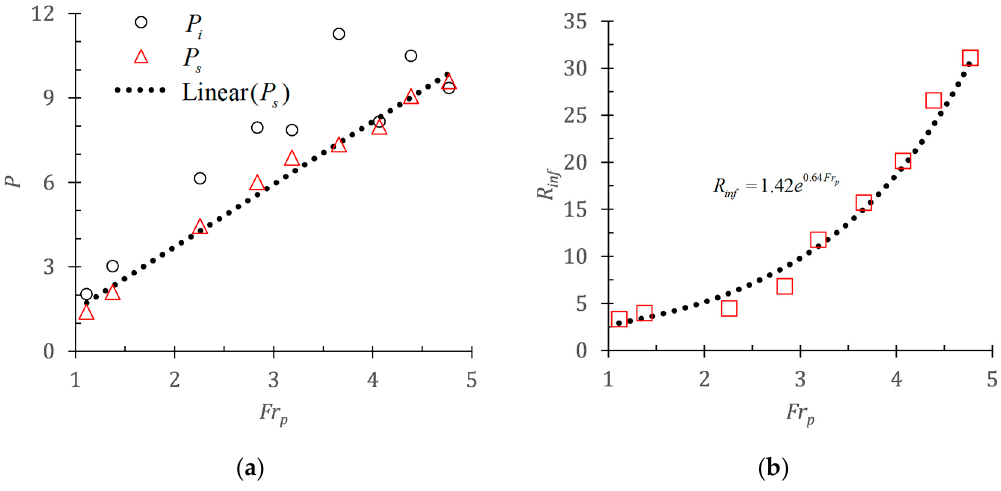
Figure 18. Dimensionless changes in the penetration height ( a ) and the horizontal influence radius ( b ) vary with Fr p .